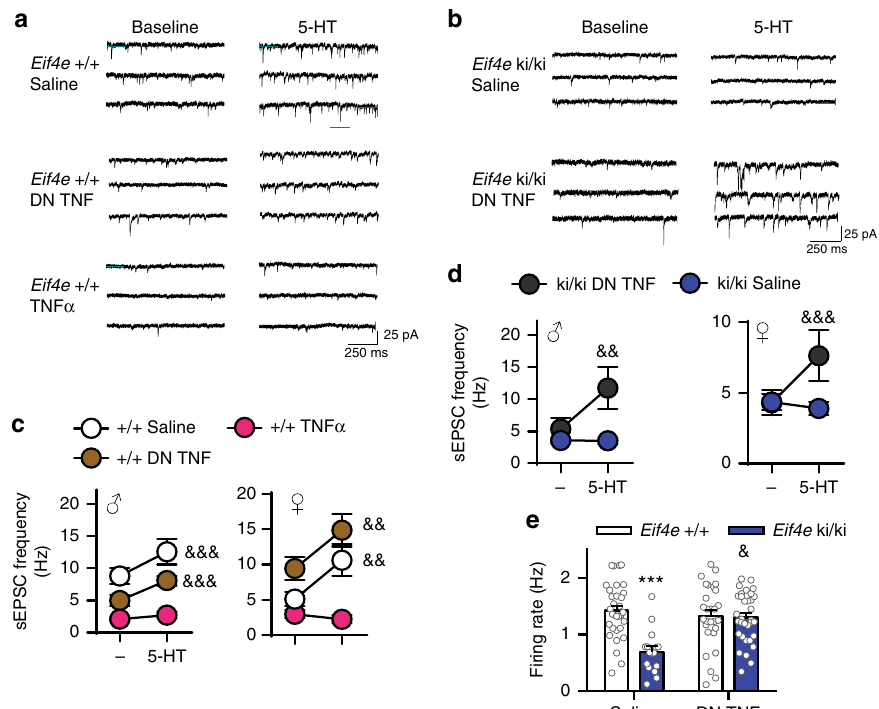
Fig. 7 TNF α causes serotonergic impairments in Eif4e ki/ki mice. a Representative sEPSC traces from mPFC pyramidal neurons in brain slices of wild-type mice treated with vehicle (saline), DN TNF (200 ng ml − 1 ) or mouse recombinant TNF α (10 ng ml − 1 ). Synaptic currents were recorded before (baseline) and after 5-HT (20 μ M) administration. b Representative sEPSC traces from Eif4e ki/ki mice treated with either vehicle or DN TNF (200 ng ml − 1